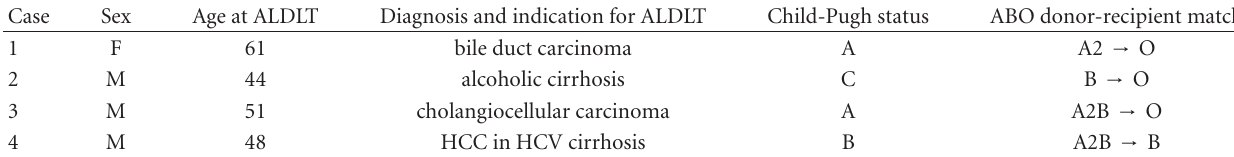
Table 1: Clinical characteristics of recipients. HCC: hepatocellular carcinoma; HCV: hepatitis C